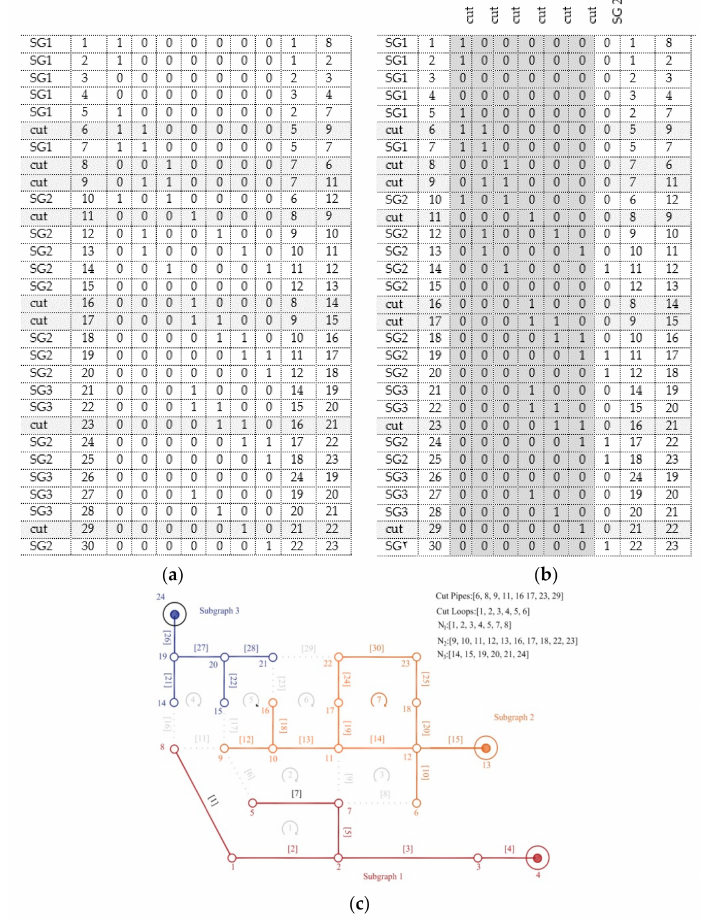
Figure 4. Pipe identification process: ( a ) identifying the pipes for each subgraph; ( b ) identifying the loops for each subgraph; ( c ) partitioning of the base